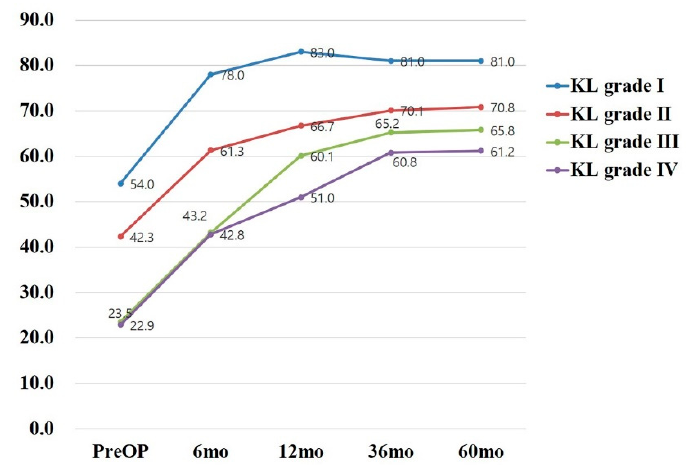
Figure 5. Knee injury and Osteoarthritis Outcome Score (KOOS) according to the K-L grade.